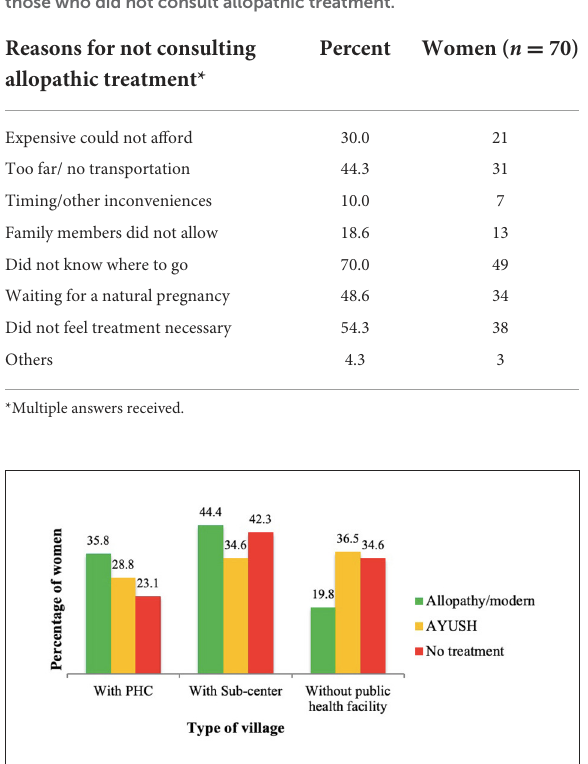
FIGURE3 Percentage of women who received treatment according to the type of